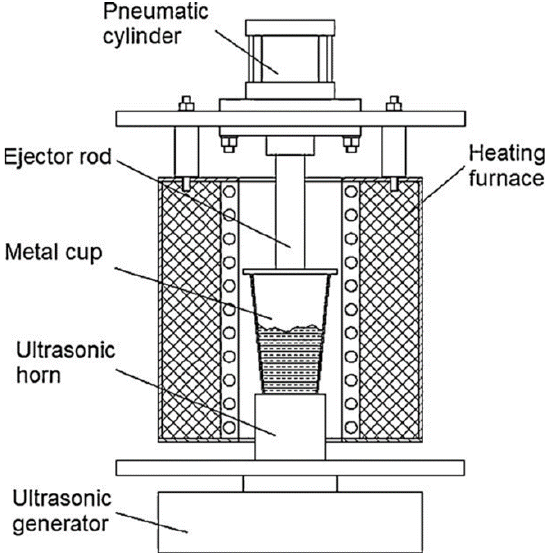
Figure 13. Schematic diagrams of the ultrasonic vibration device. Reprinted with permission from Ref. [142]. Copyright 2011 Elsevier.